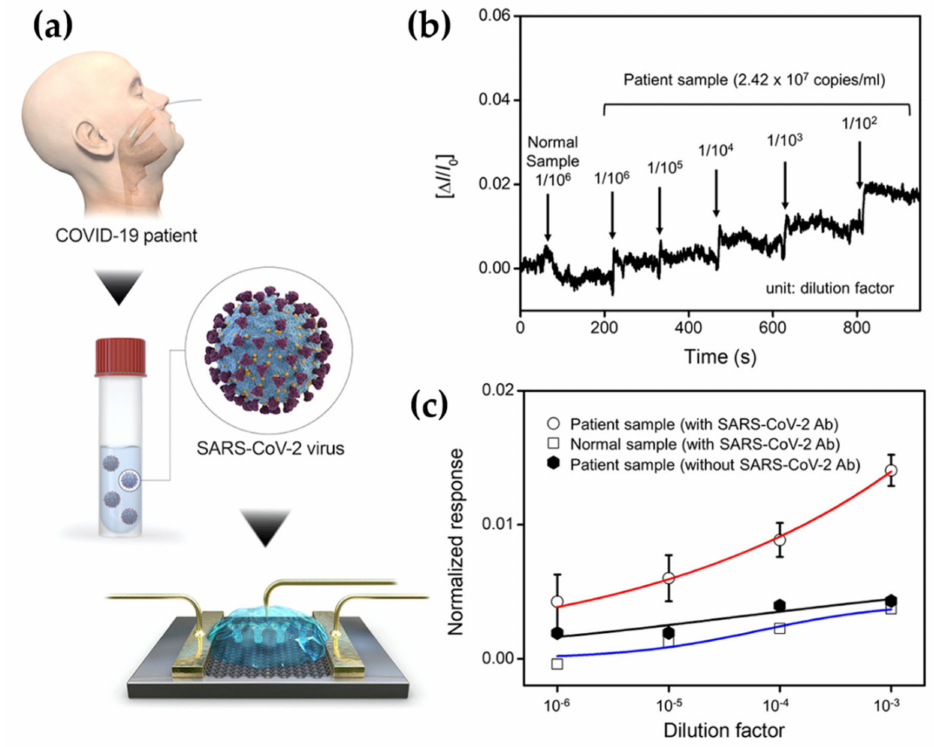
Figure 6. Graphene field-effect transistor (GFET) biosensor for the detection of the severe acute respiratory syndrome coronavirus 2 (SARS-CoV-2) in human nasopharyngeal swab specimens. ( a ) Schematic of the collection of samples and graphene field-effect transistor. ( b ) Real-time response of the GFET biosensor for various dilutions of patient samples. ( c ) Response dependence curve for the dilution factor of samples. Adapted from [57] with permission from ACS